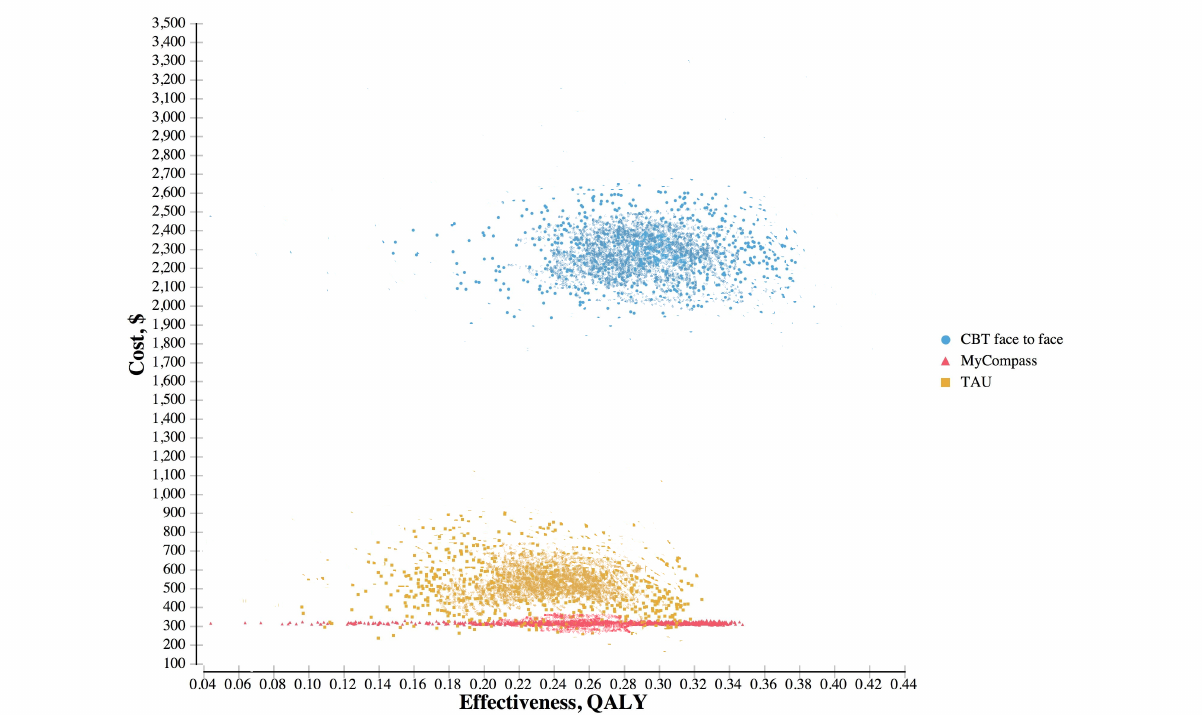
Figure 2. Sensitivity analysis - cost-effectiveness